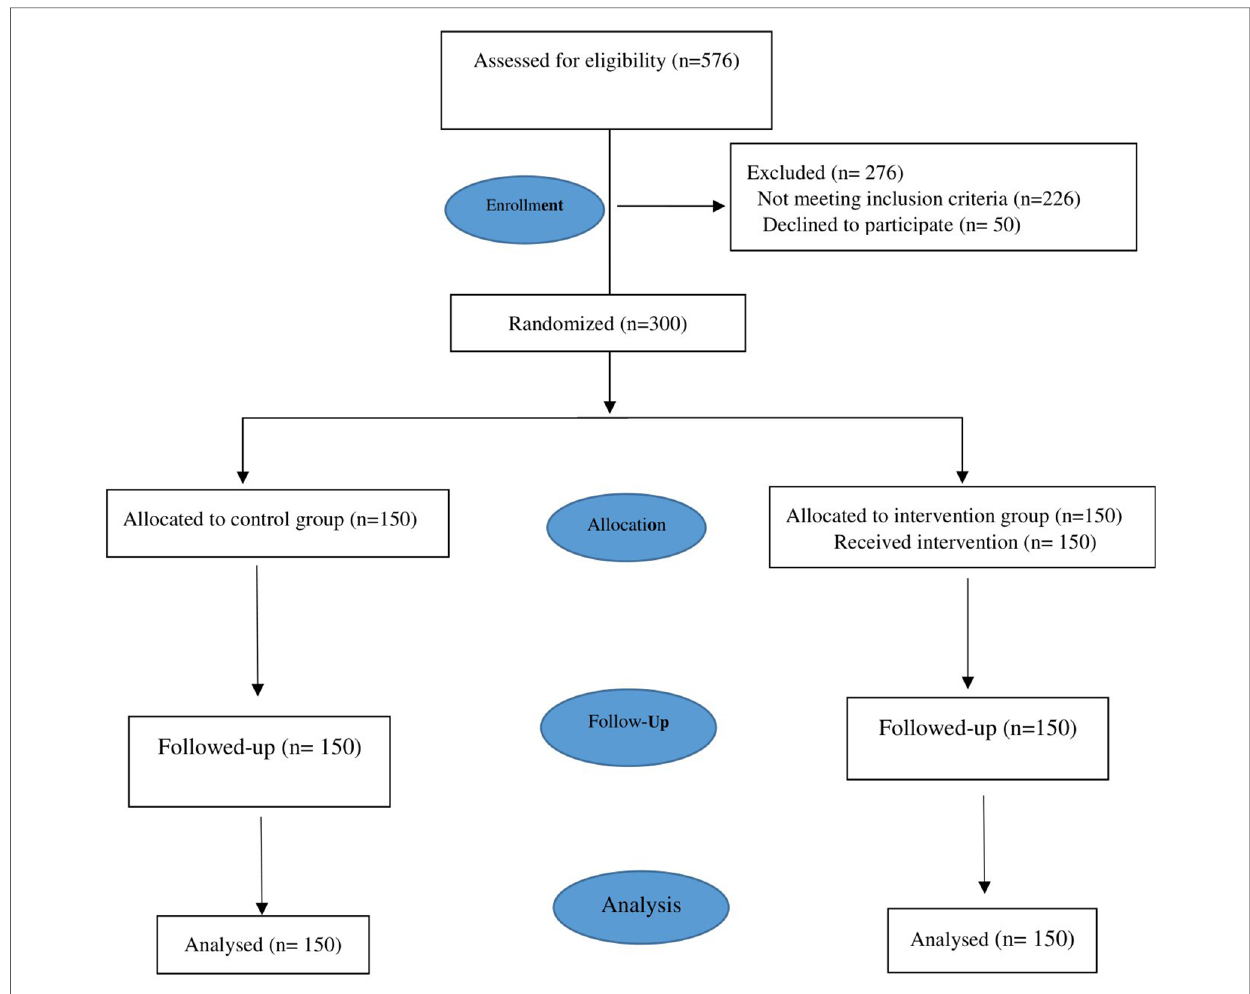
FIGURE 1 Flow-diagram of recruitment and retention of participants in the